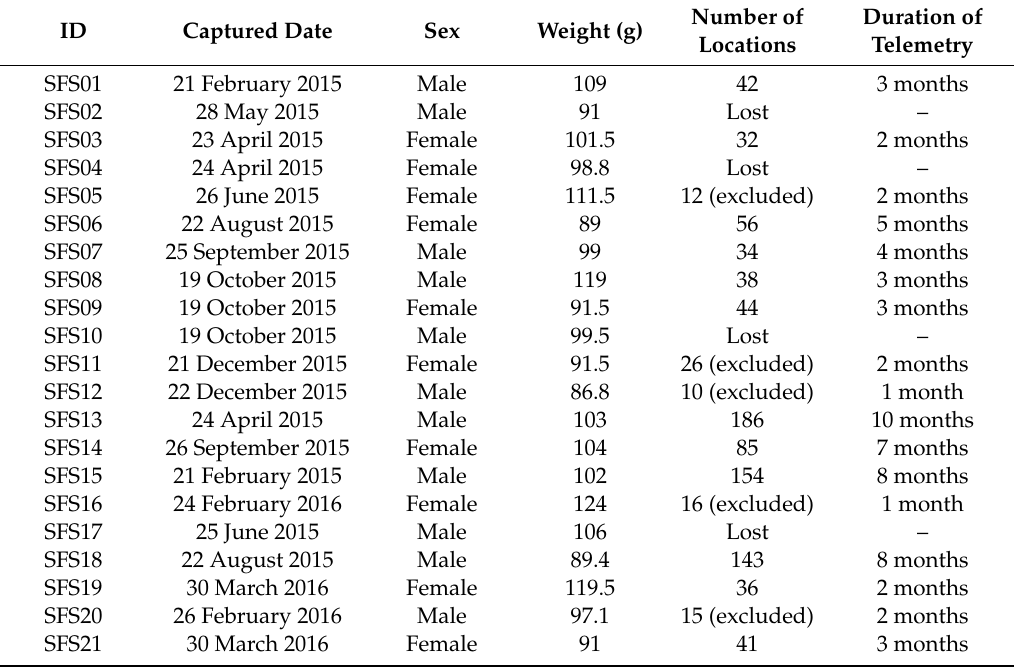
Table 2. Technical details, ID, captured date, sex, weight, number of locations, and duration of telemetry of Siberian flying squirrels at Mt. Baekwoon, Gangwon Province, South Korea.